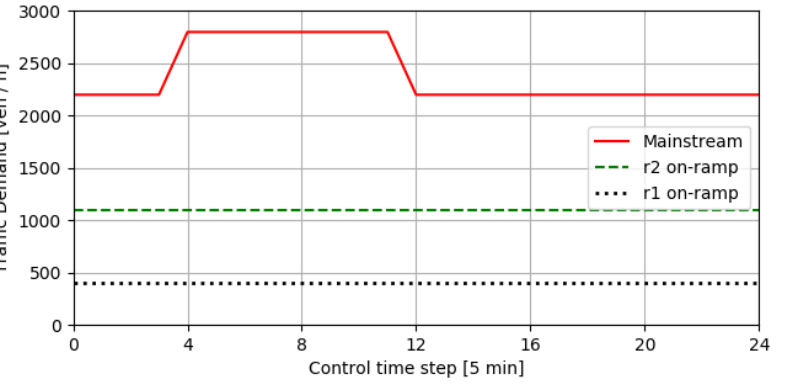
Figure 4. Traffic demand on the mainstream and on-ramps during simulation. Reprinted with permission from Ref. [8]. 2023, Filip